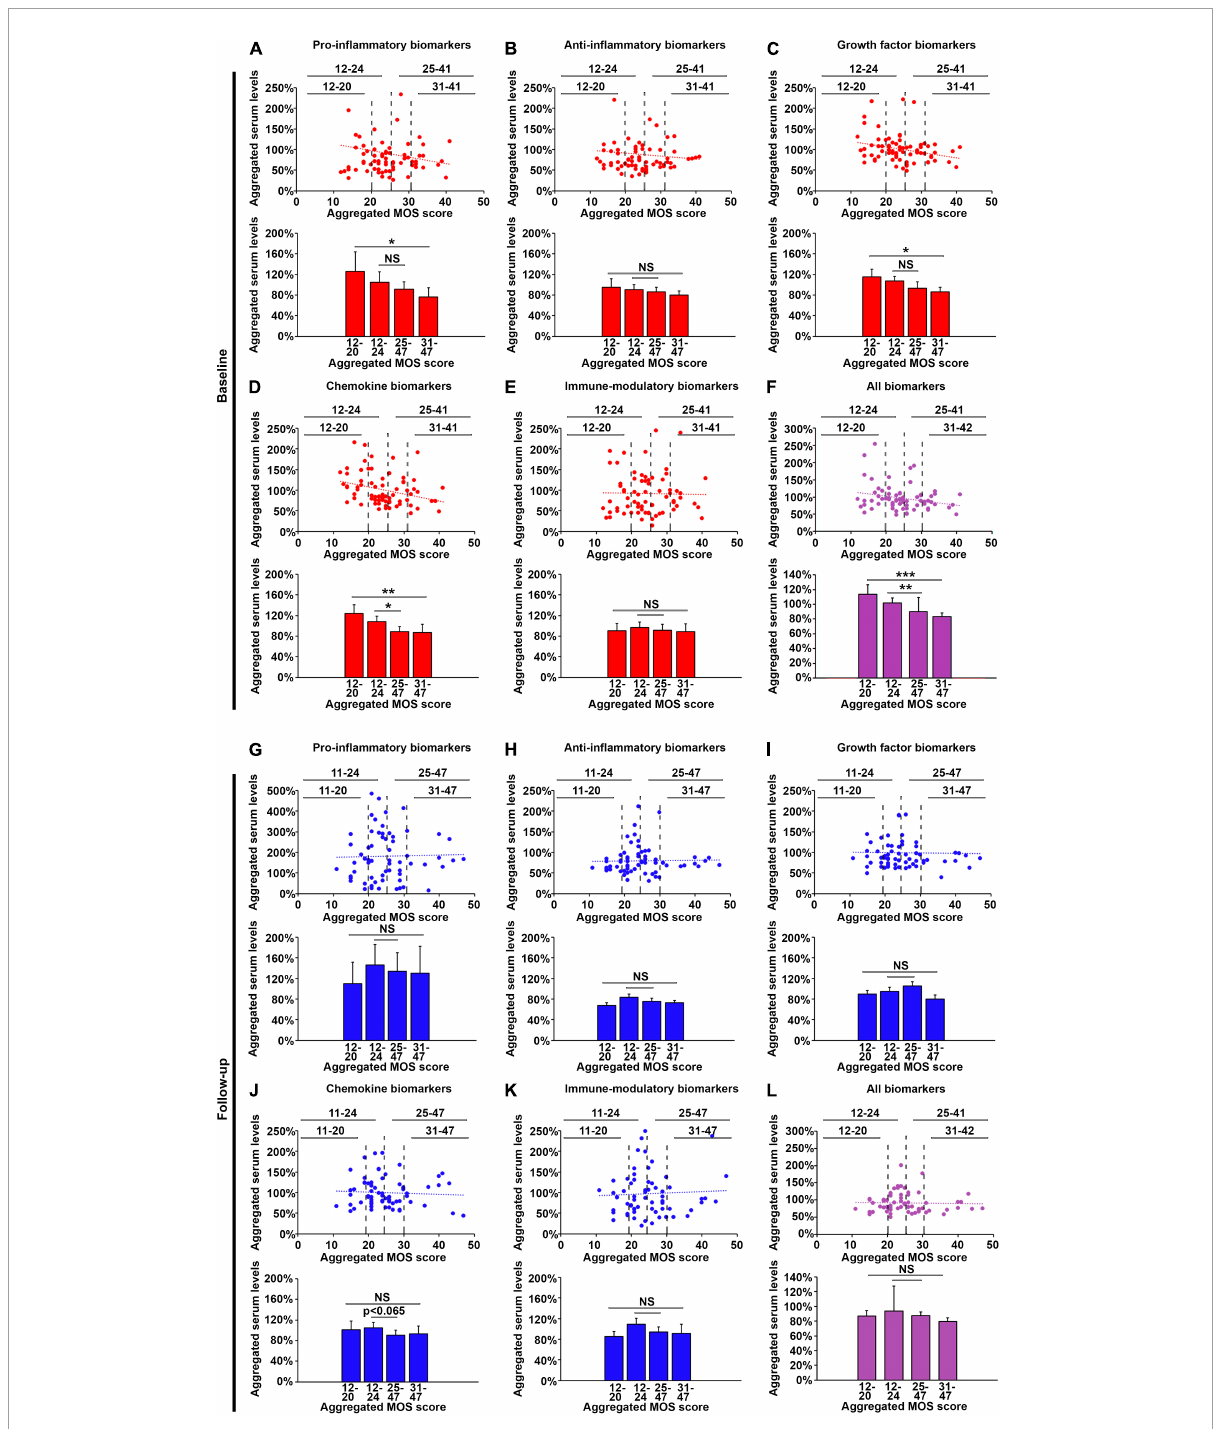
FIGURE4 Pro-inflammatory, growth factor and chemokine biomarkers in the plasma are lowered in patients exhibiting poor sleep at baseline, but not at follow-up. Average levels of normalized plasma concentrations for biomarkers in each of the five categories pro-inflammatory biomarkers (A,G) , anti-inflammatory biomarkers (B,H) , growth factor biomarkers (C,I) , cytokine biomarkers (D,J) and immune-modulatory biomarkers (E,K) , as well as for all 17 biomarkers (purple graphs, F,L ) at baseline (red graphs, A–F ) and follow-up (blue graphs, G–L ). The top graphs show the normalized, averaged levels of these biomarkers plotted against the aggregated MOS score for each patient, and the lower histographs show the averaged levels of these biomarkers for patients within four sleep quality groups: very good sleep (aggregated MOS score < 20), good sleep (aggregated MOS score < 24), poor sleep (aggregated MOS score > 25), and very poor sleep (aggregated MOS score > 31). N = 71. * p < 0.05, ** p < 0.01, *** p < 0.001, NS: